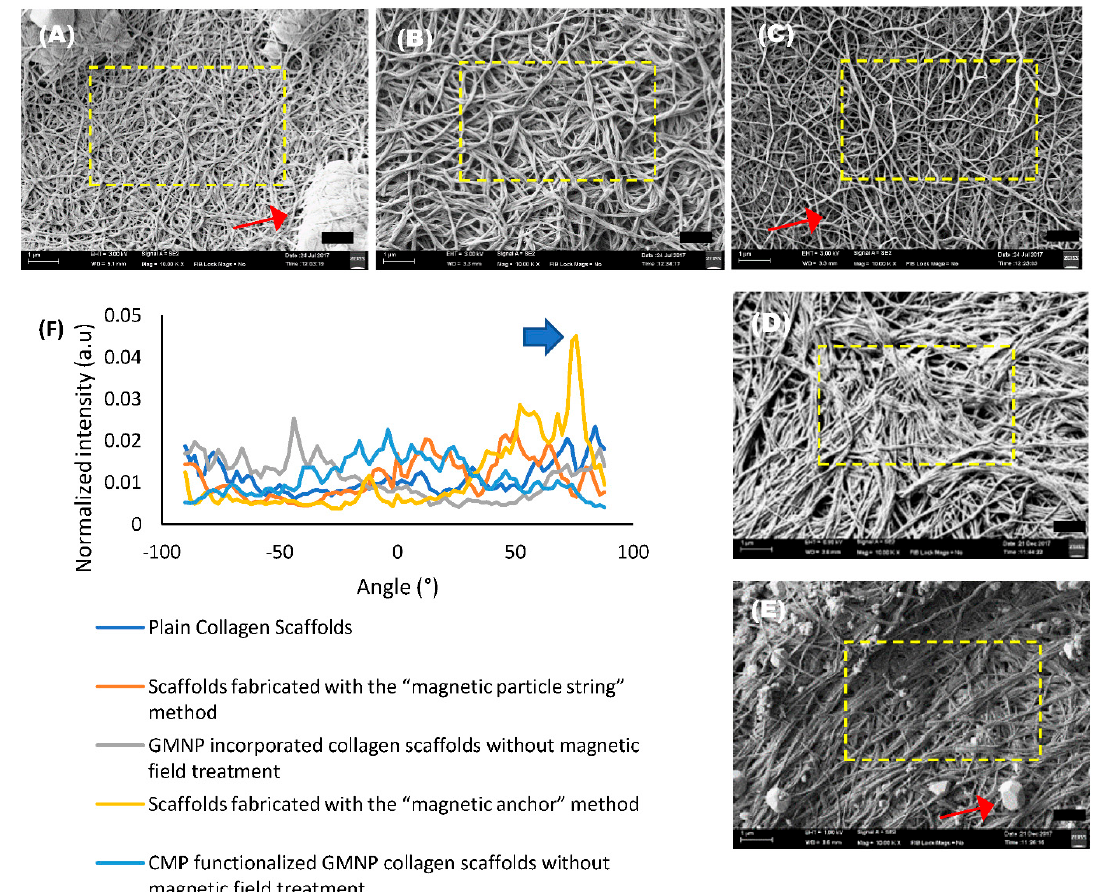
Figure 3. SEM images of collagen scaffolds and alignment analysis: ( A ) SEM image of plain collagen scaffold; ( B ) SEM image of GMNP-incorporated collagen scaffold without magnetic field treatment; ( C ) SEM image of scaffold fabricated with the “magnetic particle string” method; ( D ) SEM image of CMP-functionalised GMNP collagen scaffold without magnetic field treatment; ( E ) SEM image of scaffold fabricated with the “magnetic anchor” method; ( F ) FFT spectrum analysis plot of the areas depicted by the yellow dotted box in ( A – E ). Scale bar = 1 µm.